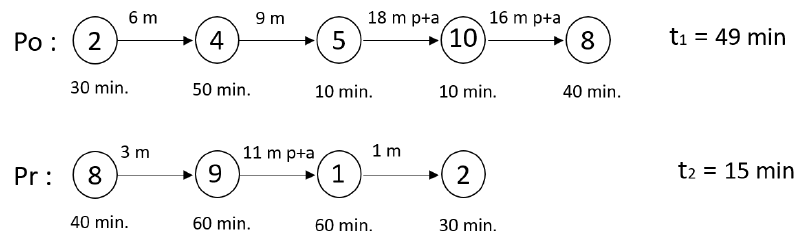
Figure 17. Algorithm 1.1 exchanges node 1 of G o with node 10 of G